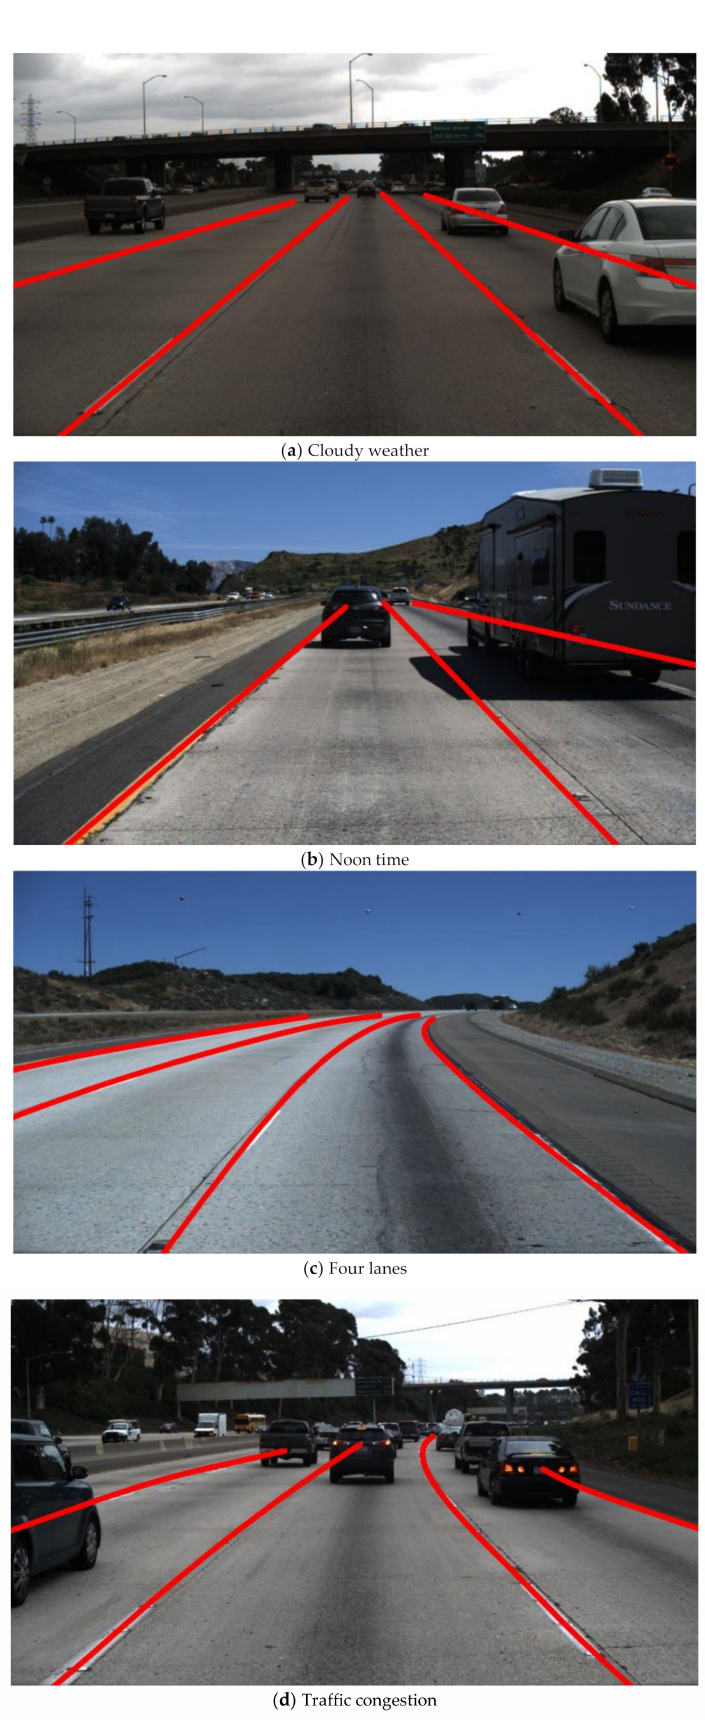
Figure 15. The lane detection results under di ff erent typical